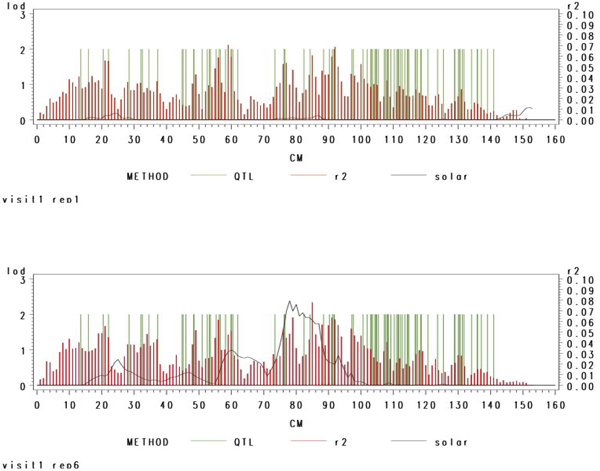
Linkage and Association vs. gene locations. HDL Visit 1 adjusted for age and sex analyzed SOLAR and regression analyses in 2-cM wide windows (moving in 1-cM increments). In Replicate 1, no evidence for linkage was found. In Replicate 2, a LOD score > 2 at ~80 cM was found.